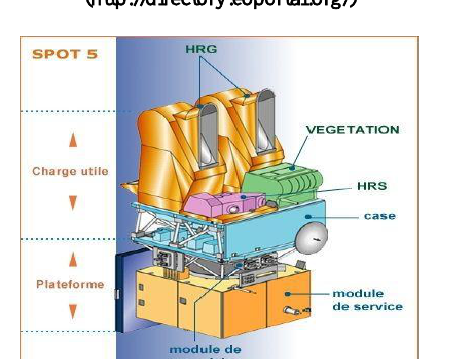
Figure 8. Schematic view of the SPOT-5 architecture